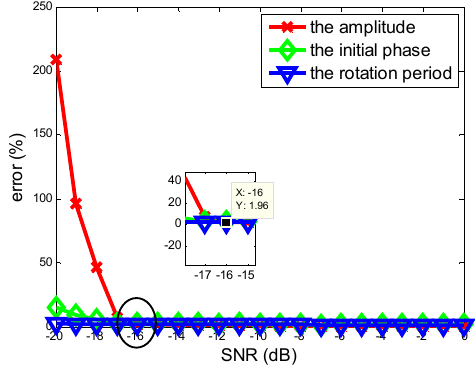
Figure 4. Relationship between signal-to-noise and the parameter estimation errors.